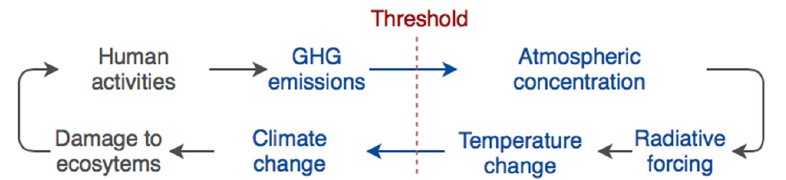
Figure 1. The cause-effect loop of greenhouse gas (GHG) emissions and climate change in blue given segments of the loop that are studied in this article. Figure adapted from Fuglestvedt et al. [25].